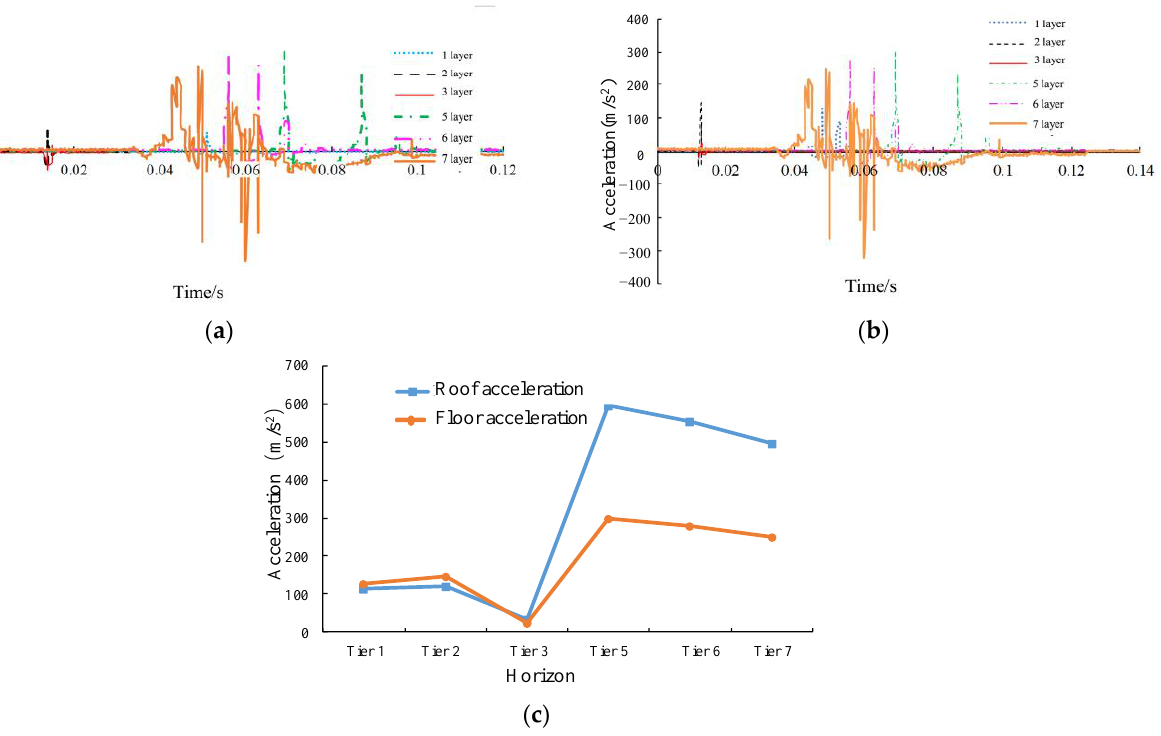
Figure 17. Acceleration response characteristics of each layer when the pendulum height is 0.3 m. ( a ) Acceleration at the roof of surrounding rock; ( b ) Acceleration at the floor of the roadway; ( c ) Peak acceleration at each level.